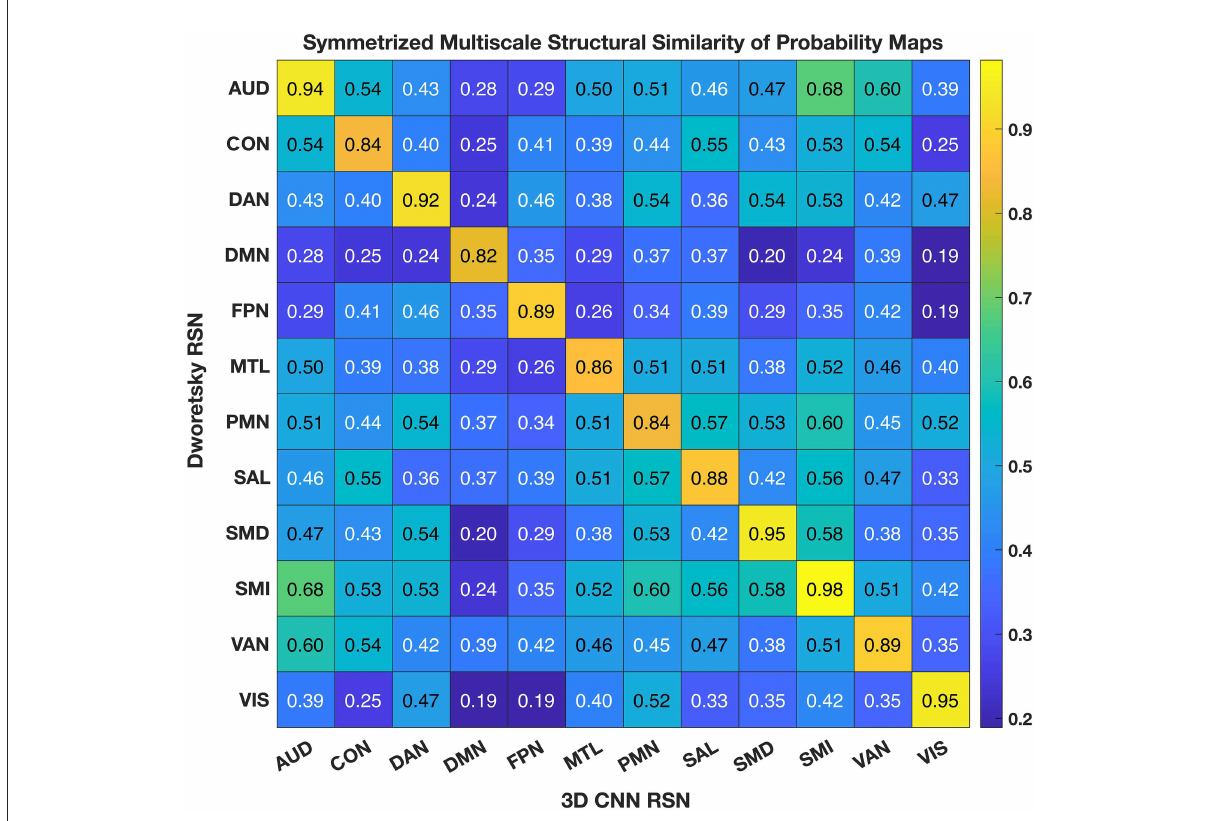
FIGURE7 3DCNN results compared to maps published by Dworetsky et al. (37). The strongest similarities were seen in AUD; VIS; SMD; and SML. SMD, dorsal somatomotor; SML, lateral somatomotor; CON, cinguloopercular; AUD, auditory; DMN, default mode; PMN, parietal memory; VIS, visual; FPN, frontoparietal; SAL, salience; VAN, ventral attention; DAN, dorsal attention; MTL, medial temporal; and REW, reward.